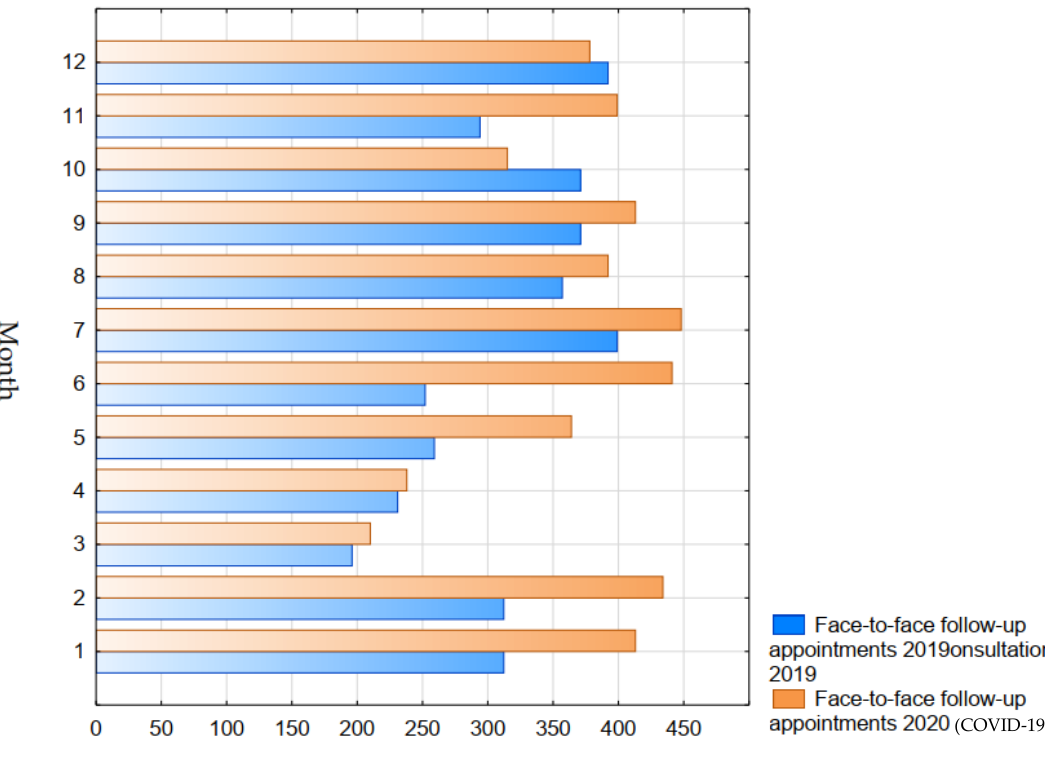
Figure 3. Change in the number of face-to-face patient follow-up appointments during the pandemic period from the prepandemic period.